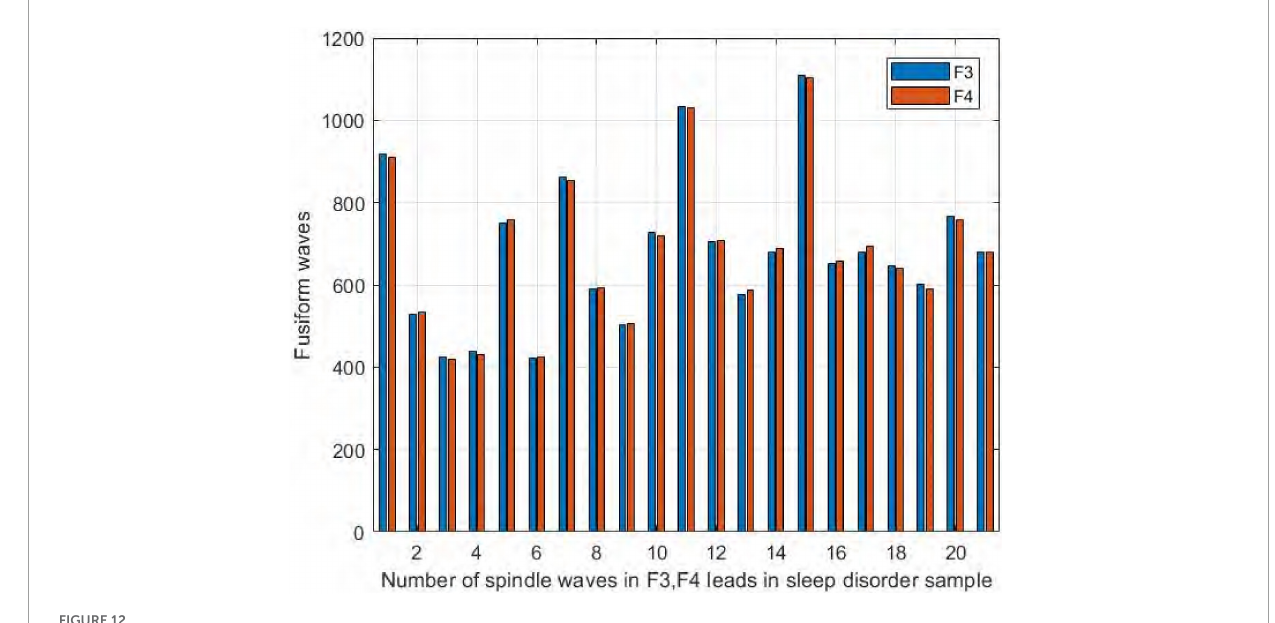
FIGURE12 Comparison of the number of spindles in channels F3 and F4 in the sleep-disordered subjects.